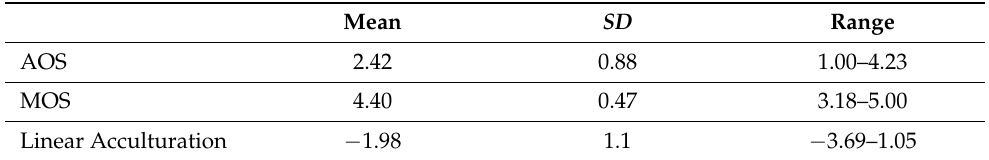
Table 2. Mothers’ mean Anglo-American orientation (AOS), Mexican orientation (MOS), and linear acculturation scores, standard deviations, and ranges.